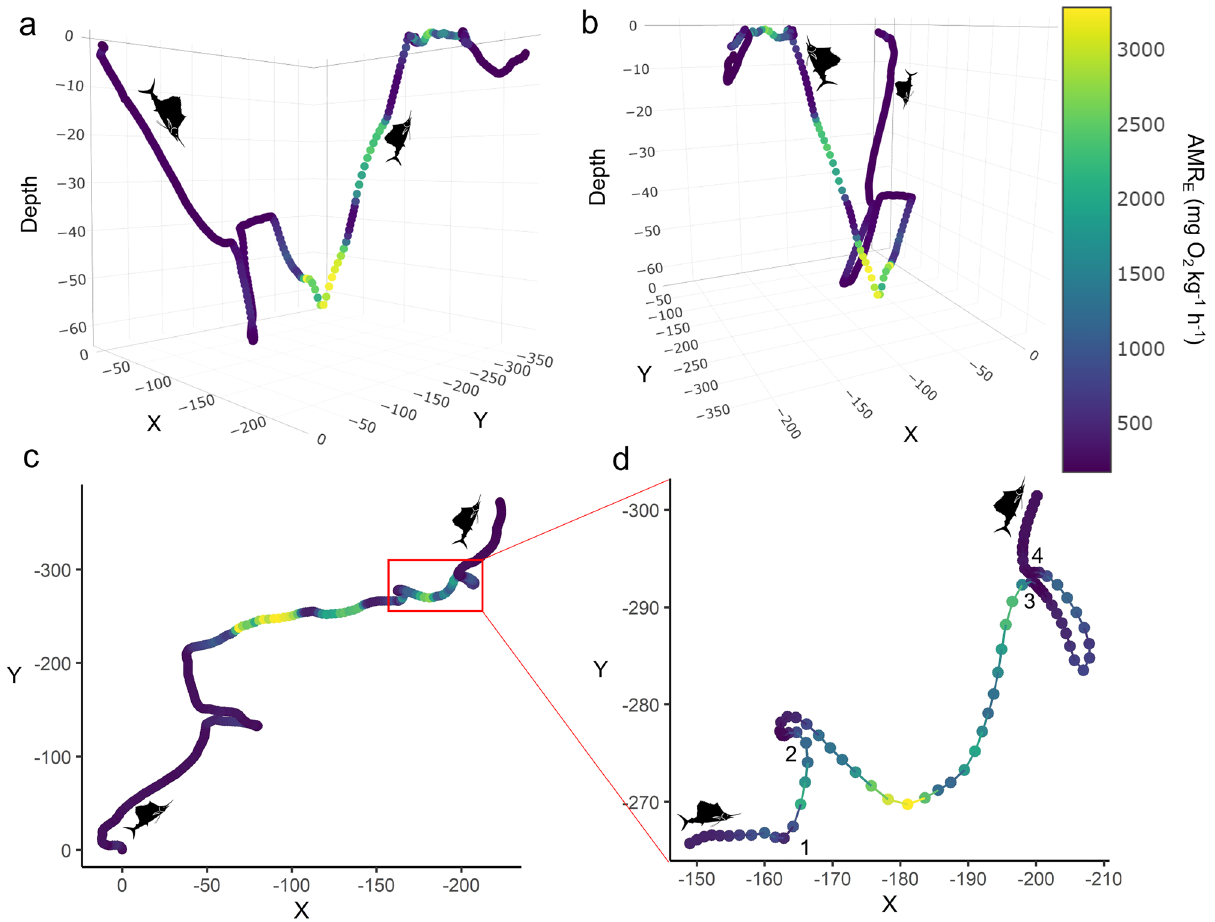
Figure 3. Reconstructed track of the dive in which the predation event took place, colored by the estimated active metabolic rate (AMR E ; mgO 2 kg −1 h −1 ). ( a ) and ( b ) show different perspectives of the depth profile and associated changes in direction, while ( c ) and ( d ) are overhead views, with ( d ) being zoomed in on the pursuit portion at the surface. The numbers displayed in ( d ) represent the approximate location of the sequential capture attempts displayed in Fig. 4, and as seen in the supplemental video. Sailfish silhouettes indicate direction of travel.